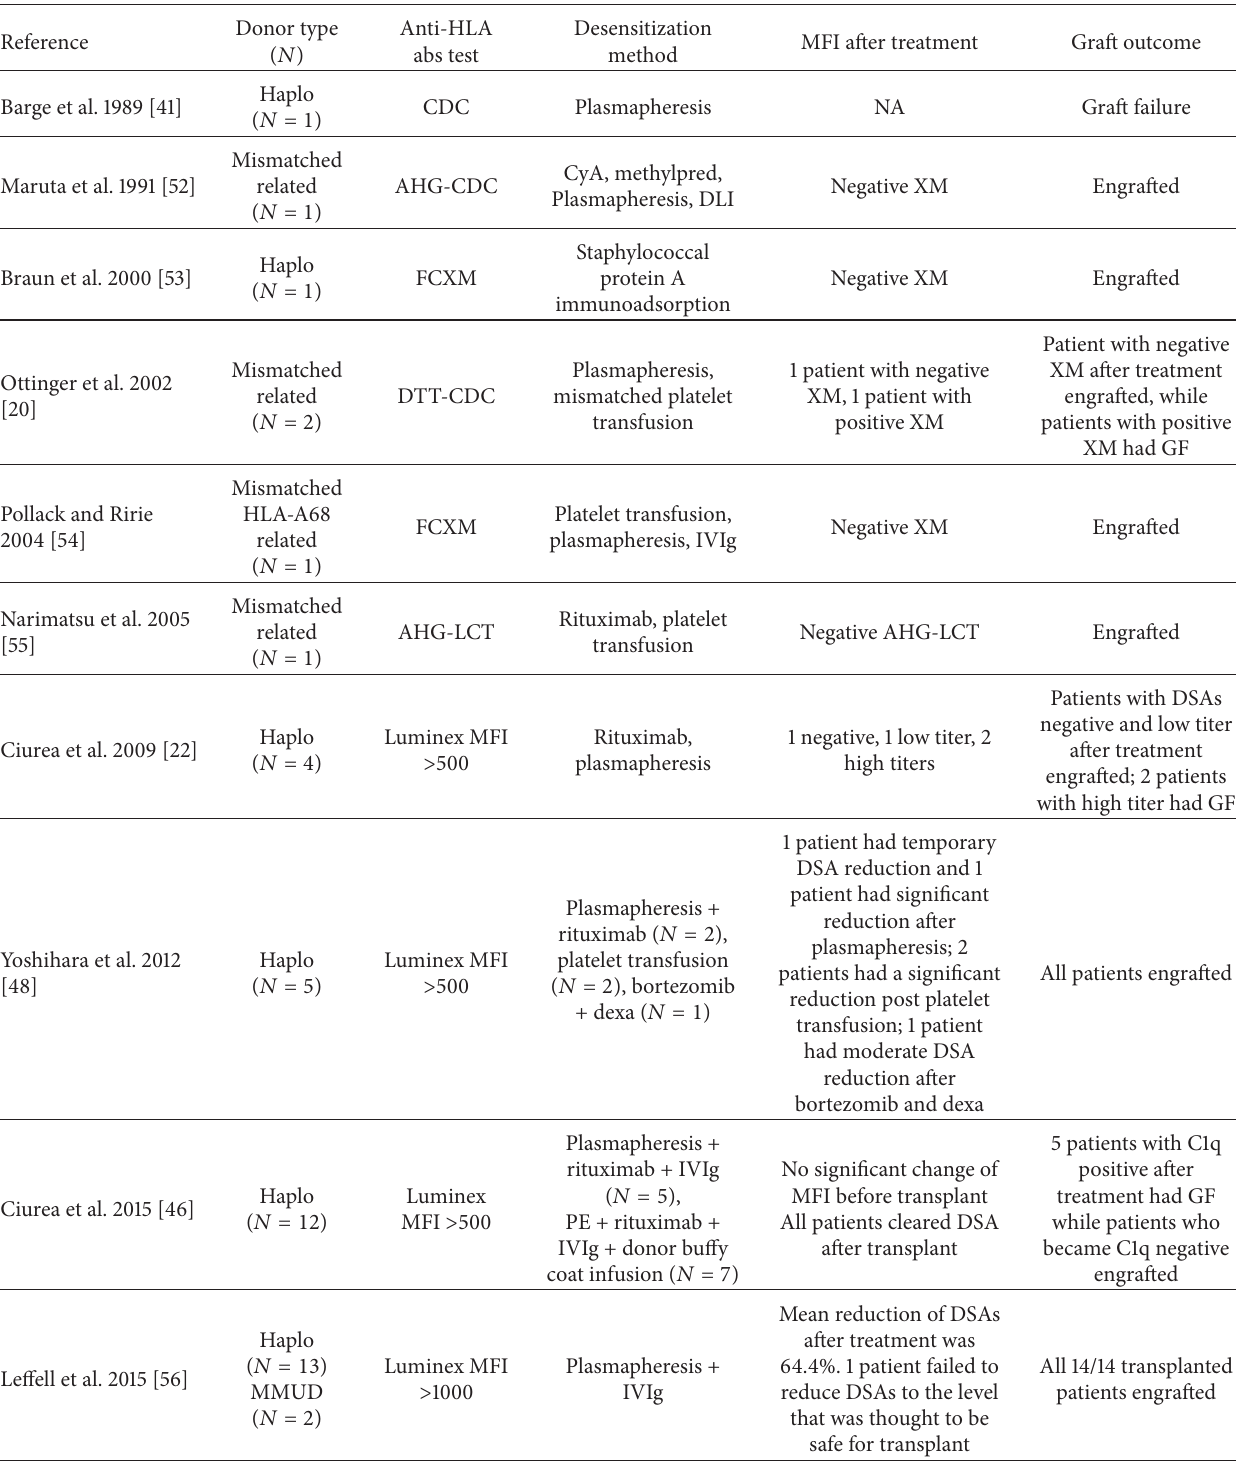
Table 2: DSA desensitization in haploidentical and mismatched related